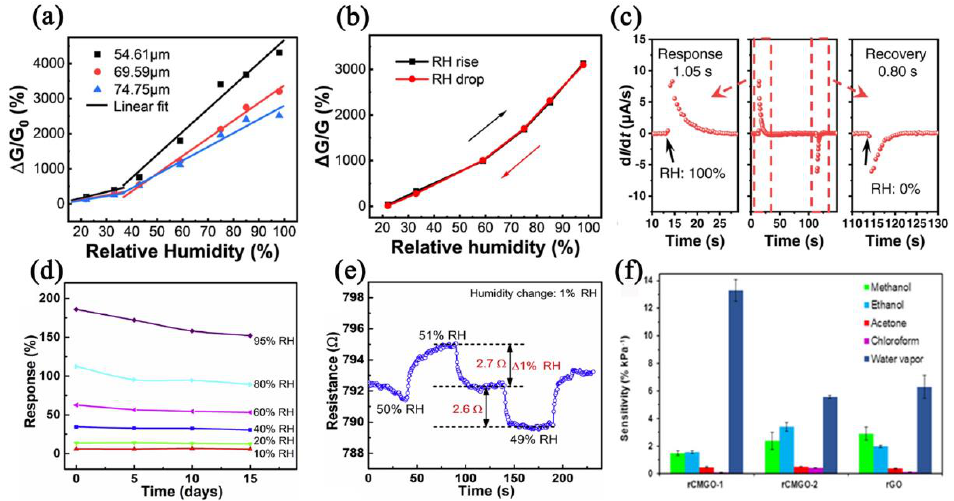
Figure 3. ( a ) Schematic diagram of response curves. ( b ) Schematic diagram of hysteresis curves. Reproduced with permission from Ref. [17]. Copyright 2022, Springer Nature. ( c ) Schematic diagram of response/recovery curve and corresponding response time and recovery time. Reproduced with permission from Ref. [61]. Copyright 2022, Springer Nature. ( d ) Schematic diagram of impedance values vs. time. ( e ) Schematic diagram of response curve of a humidity sensor to 1% RH change (resolution). Reproduced with permission from Ref. [21]. Copyright 2021, Elsevier. ( f ) Schematic diagram of selectivity of a humidity sensor to different gas vapor. Reproduced with permission from Ref. [66]. Copyright 2014, American Chemical Society.